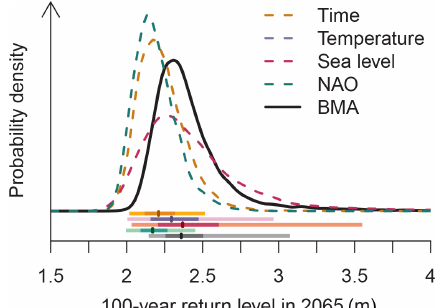
Figure 4. Empirical probability density functions for the 100-year storm surge return level (meters) at Norfolk, Virginia, as estimated using Bayesian model averaging with one of the four candidate co- variates and using the overall Bayesian model averaging ensemble with all 13 distinct candidate model structures. The bar plots pro- vide the 5%–95% credible range (lightest shading), the interquar- tile range (moderate shading) and the ensemble medians (dark ver- tical line). The shaded bar plots follow the same order as the